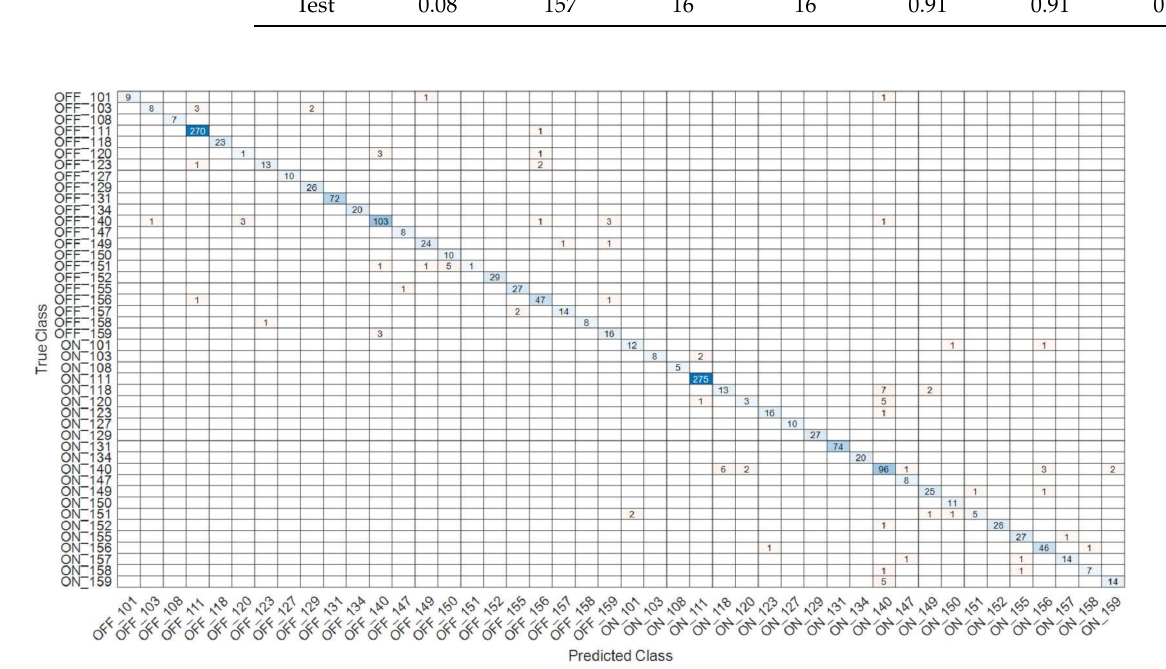
Figure 6. Confusion matrix for the entire